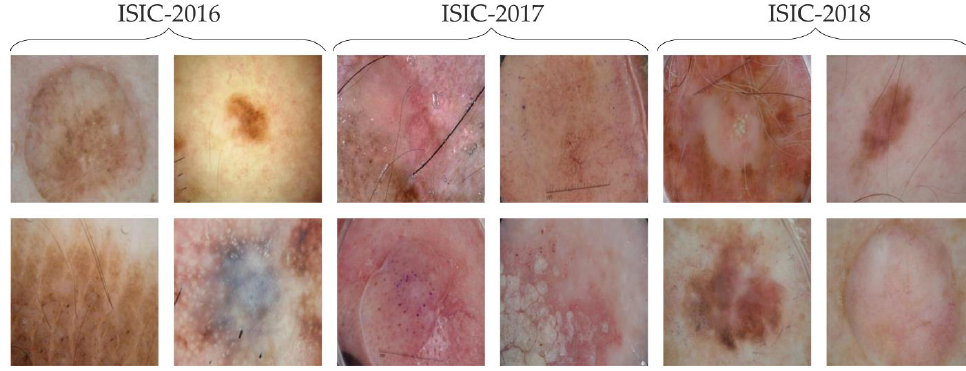
Figure 1. ISIC 2016, 2017 and 2018, four samples